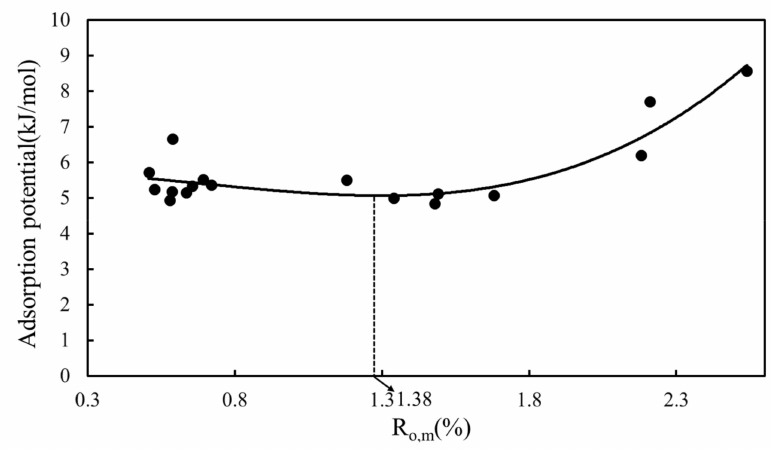
Figure 12. Relationship between coal rank and adsorption